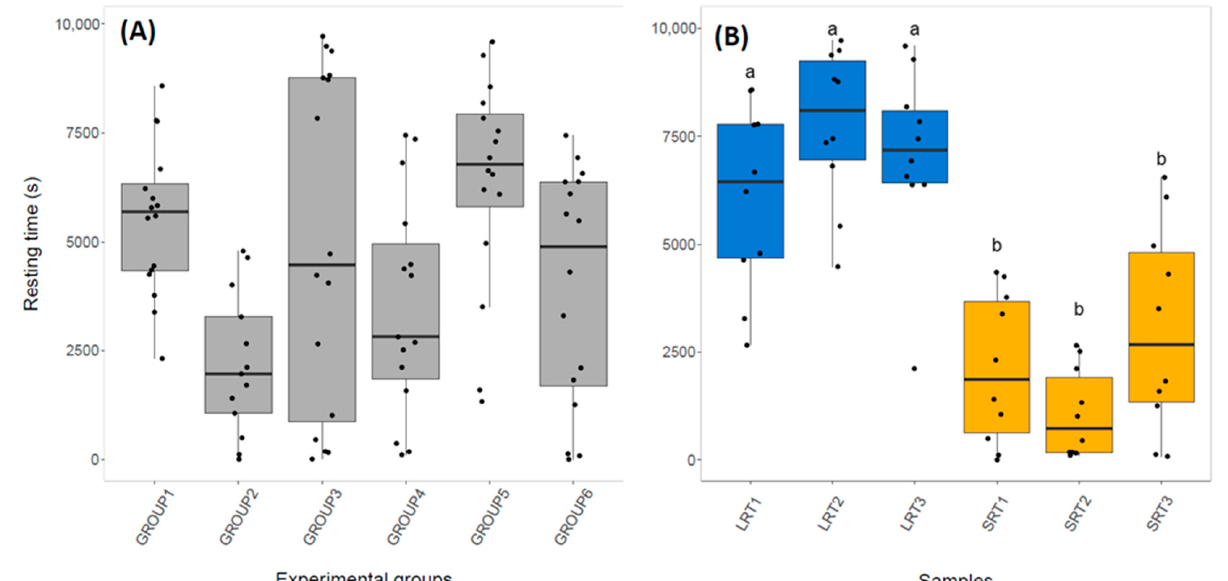
Figure 1. ( A ) Time spent under shelter for experimental groups and ( B ) for long resting time (LRT) and short resting time (SRT) individuals and groups. Letters indicate whether resting times differed significantly (a summary of Dunn test results can be seen in Table